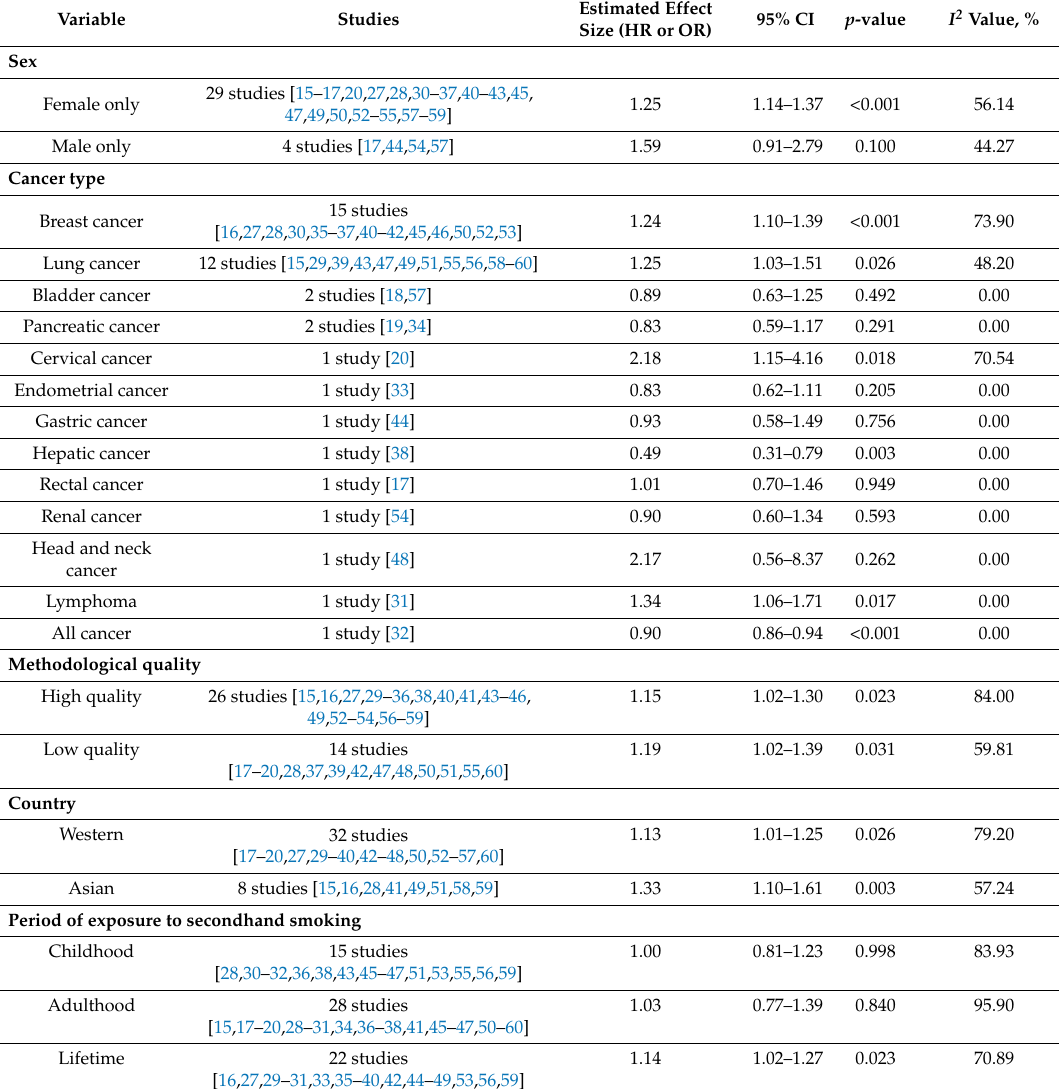
Table 2. Subgroup analysis in the random-effects